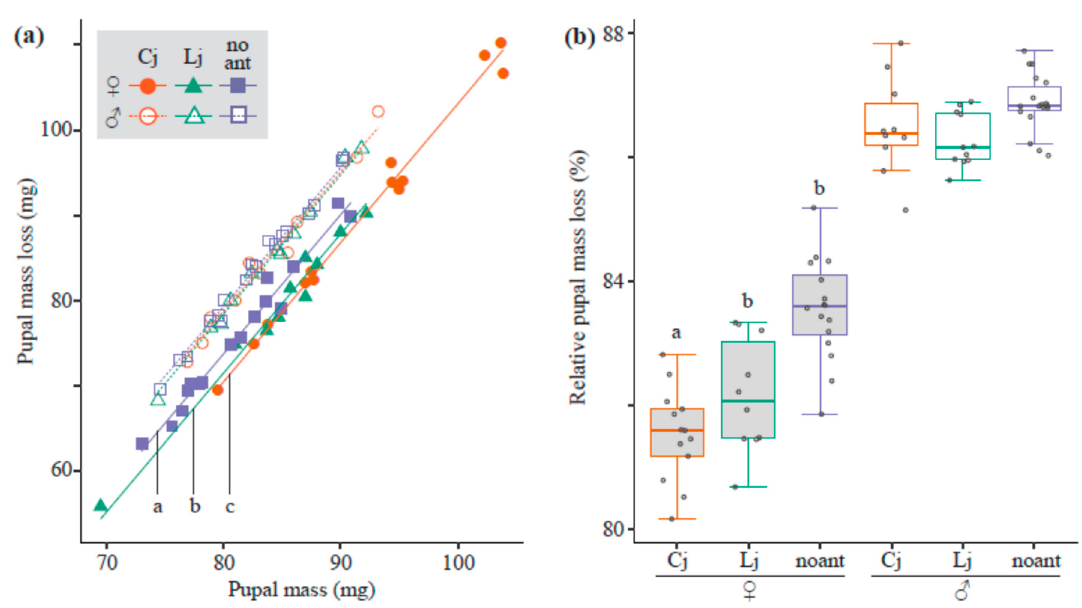
Figure 2. Pupal mass loss and relative pupal mass loss. The plot shows the relationship between pupal mass loss and pupal mass ( a ). Different shapes, such as points, orange circles, green triangles, and blue squares, and different line types, including sold, dotted, and dashed, represent different ant-tending conditions; larvae tended by C. japonicus (Cj), by L. japonicus (Lj), and untended larvae (no ant), respectively. Solid and open symbols represent female and male larvae, respectively. The boxplot shows relative pupal mass loss among ant tending conditions (Cj: orange, Lj: green, no ant: blue) and between sexes of lycaenids (female: gray boxes, male: white boxes) ( b ). All the data points are shown as dots. Dots outside boxes and whiskers are outliers. In both graphs, different letters represent significant differences.